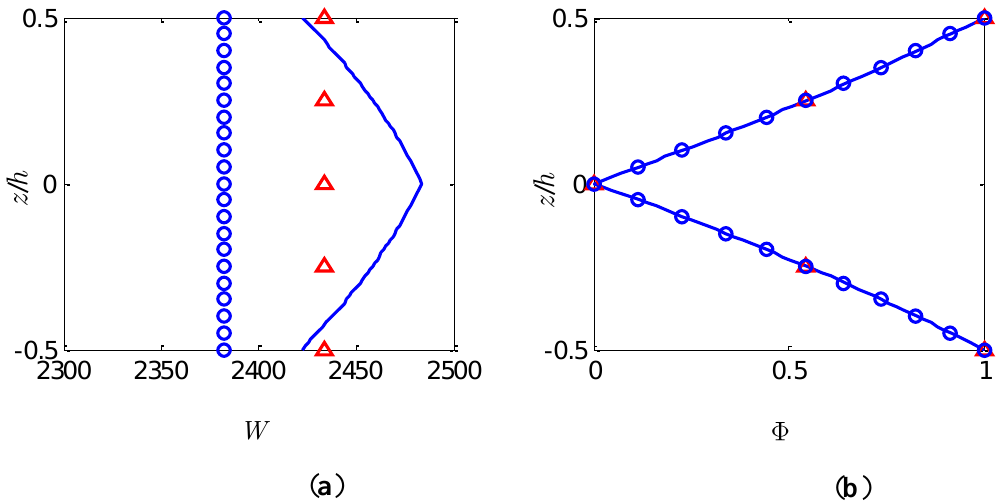
Figure 8. Bimorph actuator of 50 S under potential load. ( a ) Dimensionless deflection; ( b ) Dimensionless electric potential. 3-D FE analysis (full line), present model with 2 n (triangles) and present model with 10 n (small